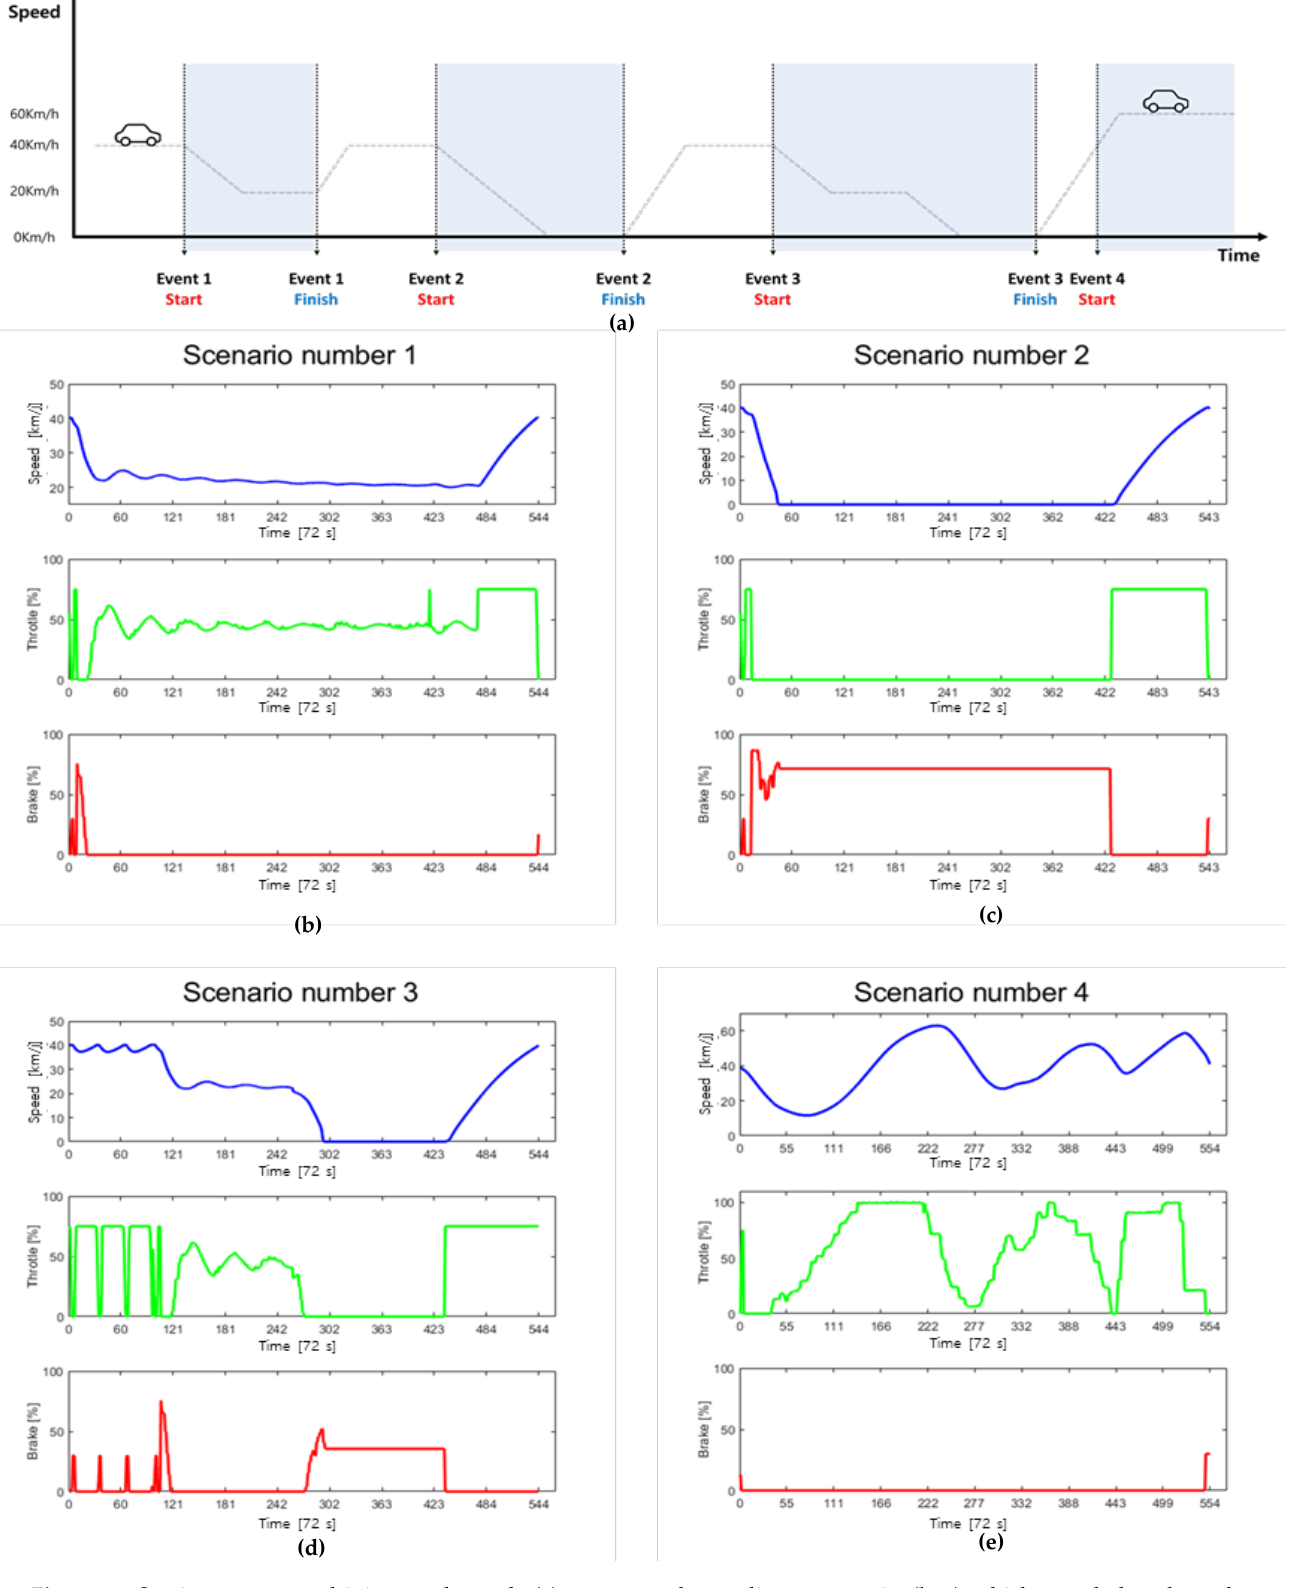
Figure 10. Semi-autonomous driving result graph; ( a ) target speed according to scenario; ( b – e ) vehicle speed, throttle, and brake value graphs in each scenario.